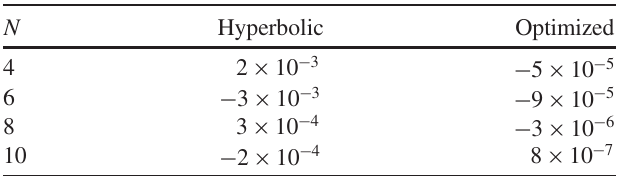
TABLE III. First normalized systematic integrated harmonics b =b N 2 , expressed at 7 mm, for hyperbolic and optimized pole shapes (RADIA simulations).